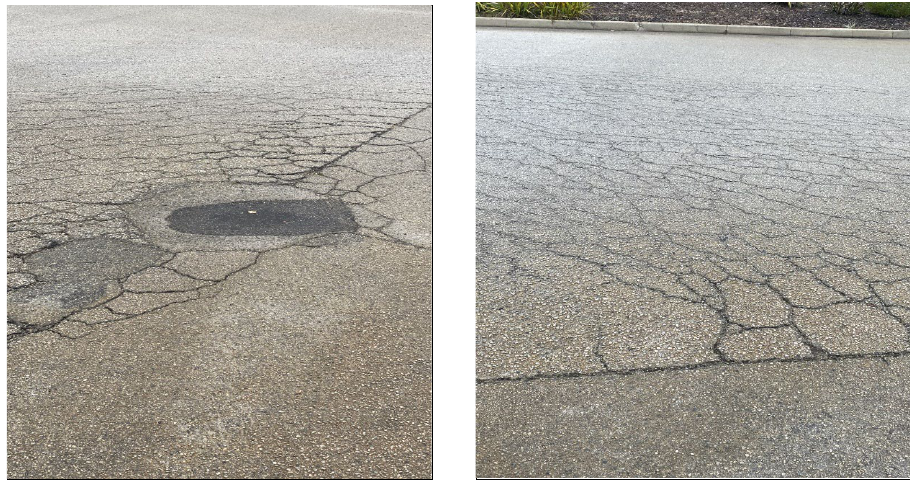
Figure 1. Pavement deformation and cracking (photos by